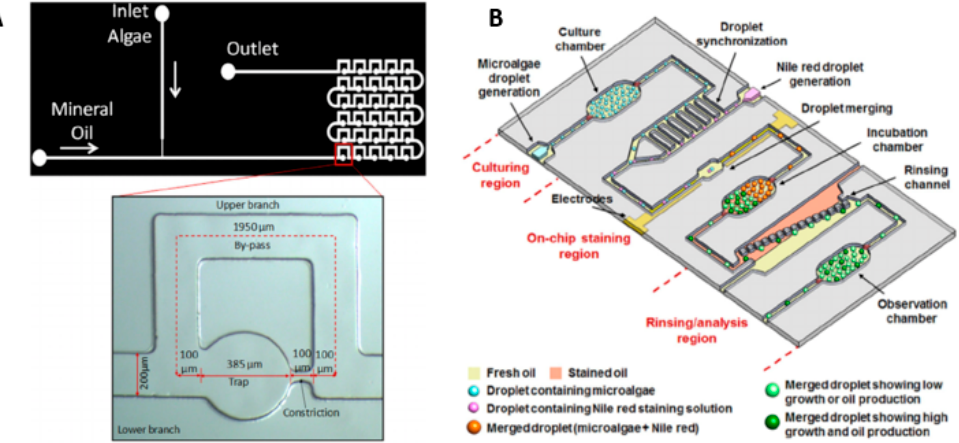
Figure 4. High-throughput droplet or digital microfluidics platform for microalgae culture and anal- ysis. ( A ) Schematic diagram of the PDMS microfluidic device and the magnified image of a loop highlighting the various geometric dimensions. Reproduced with permission from [69] A.